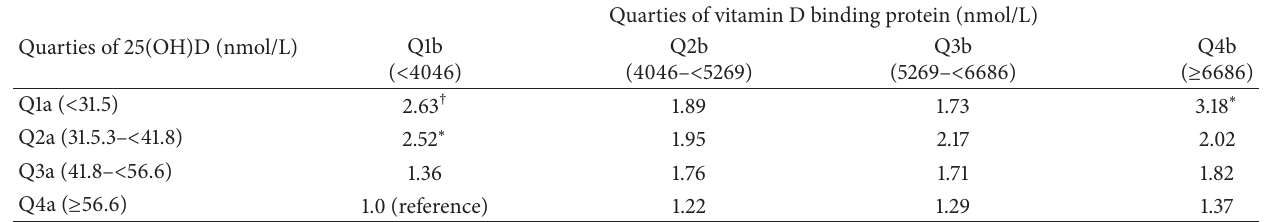
Table 3: Odds ratios of being frail versus nonfrail of participants across quarties of 25(OH)D and DBP levels. Quarties of vitamin D binding protein Quarties of 25(OH)D (nmol/L)